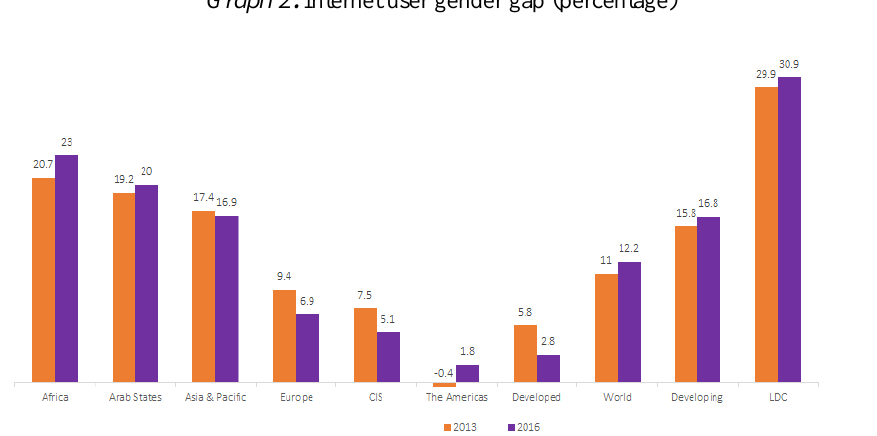
Graph 2. Internet user gender gap